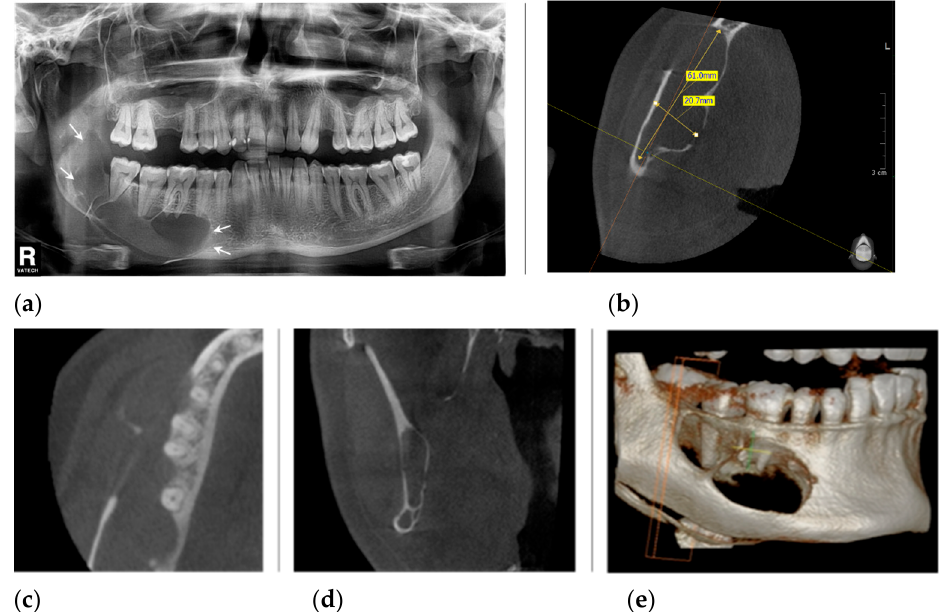
Figure 2. The radiological aspect before surgical treatments: ( a ) panoramic radiograph shows a large multilocular lesion occupying the body of the mandible, from the right second premolar to the ascendent ramus (arrows), without involving the condyle or coronoid process, and inferior displacement of the mandibular canal; ( b ) the CBCT, axial view shows the lesion measuring 61 mm in length and 20.7 mm in width; ( c ) the CBCT image indicates that the apices of the first and second molar are in the unaffected bone structure; ( d ) the CBCT, coronal view of the ascending ramus, indicates the condyle is not involve; ( e ) the CBCT, 3D reconstruction view.